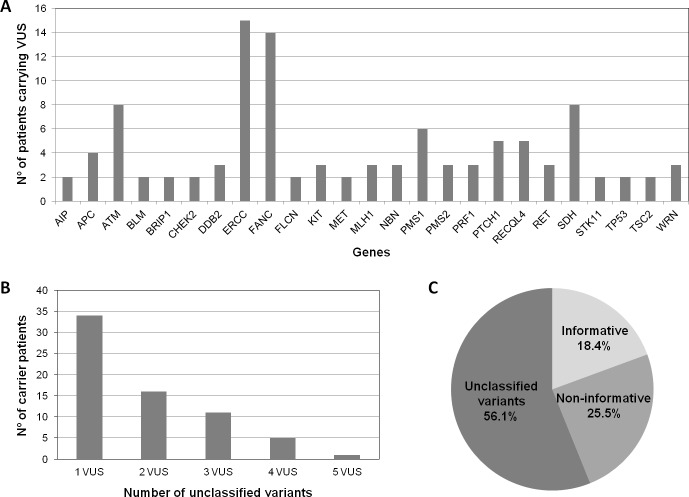
Class 3 variants found in genes implicated in hereditary cancer and clinical experience.A) Number of rare VUS (MAF<0.005) per gene or group of genes, in those cancer susceptibility genes with at least 2 filtered VUS. The different FANC, ERCC and SDH genes were grouped together for simplification. B) Number of unclassified variants per patient of the study cohort. C) Clinical practice experience with multigene panel study. VUS: variants of unknown significance.